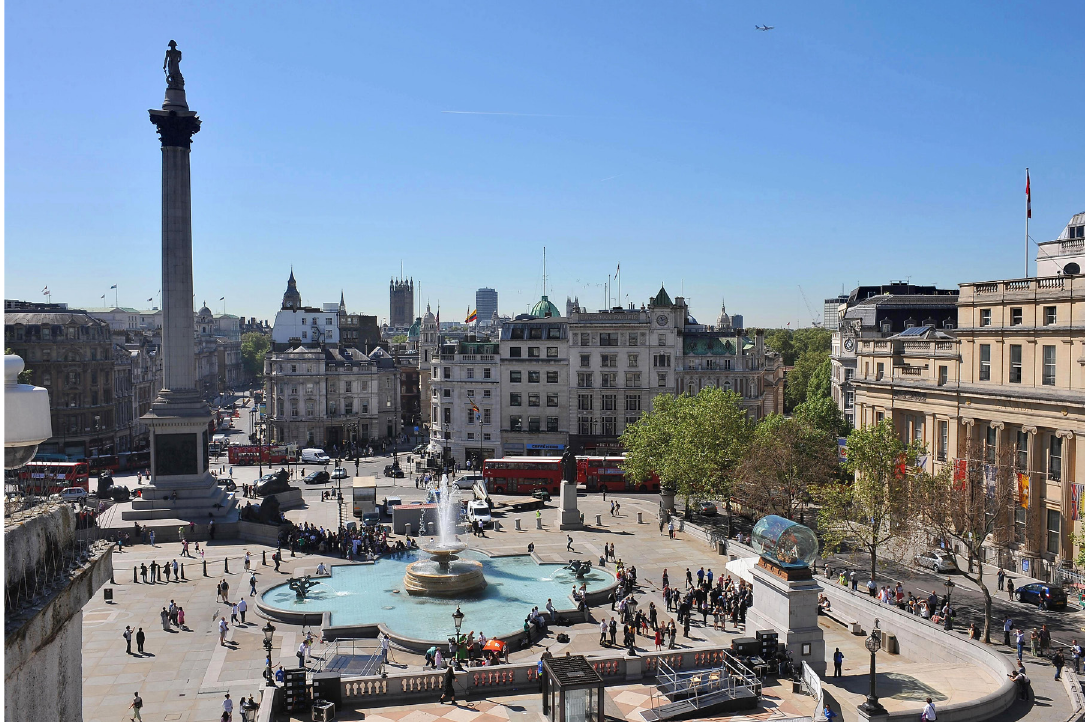
Figure 3: View of Trafalgar Square showing Nelson’s Ship in a Bottle on the Fourth Plinth. Photograph by PA Images/Alamy Stock Photo. Sculpture © Yinka Shonibare MBE. All Rights Reserved, DACS / ARS, NY